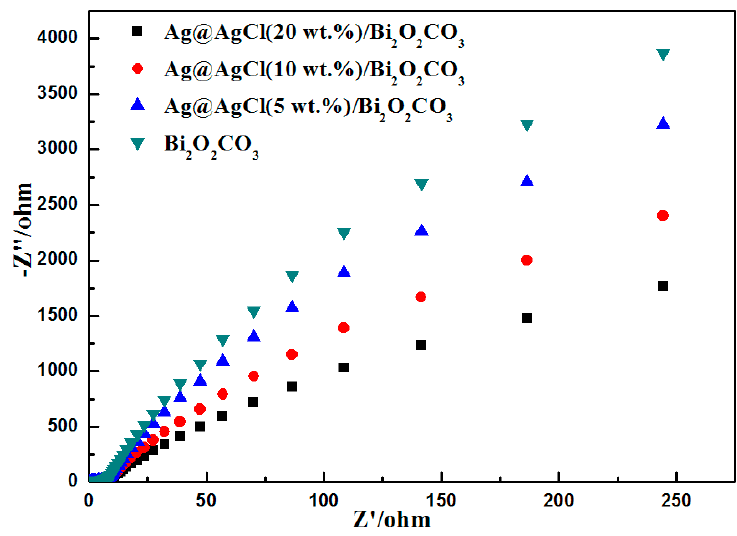
Figure 12. EIS spectra of synthesized Bi 2 O 2 CO 3 , Ag@AgCl (5 wt %)/Bi 2 O 2 CO 3 Ag@AgCl (10 wt %)/Bi 2 O 2 CO 3 and Ag@AgCl (20 wt %)/Bi 2 O 2 CO 3 .